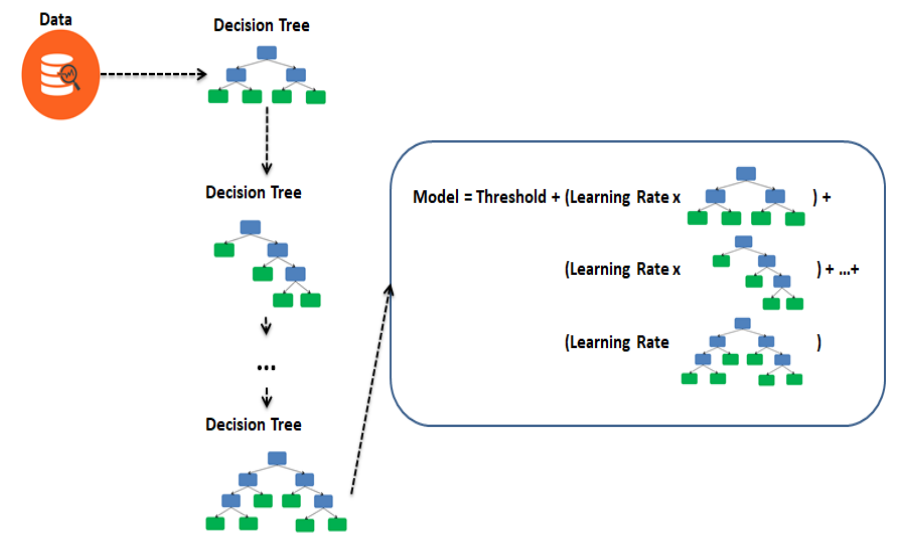
Figure 4. Extreme Gradient Boosting (XGBoost) modeling process diagram.